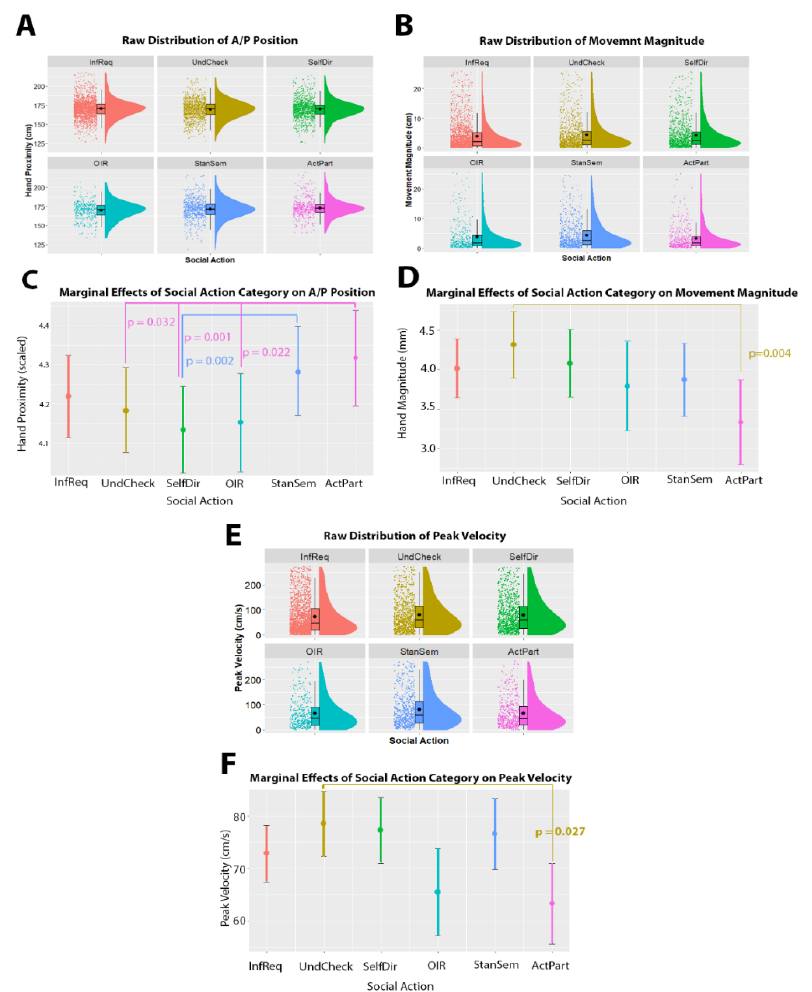
Figure 4. Relationship between hand movement and social action category. Panels ( A , C , E ) show raincloud plots of the raw distribution ( y -axis) across each of the social action categories ( x -axis). The raincloud plots show the overall density of the distribution (shaded curve), the boxplots show the median and interquartile range, while the black dots show the individual data points. Panels ( B , D , F ) depicts the marginal effects of the mixed model (i.e., the predicted values when holding other model terms, such as utterance duration and per-participant intercepts, constant). In panels ( B , D , F ) social action categories are given on the x -axis, and kinematic values are given on the y -axis Note that anterior/posterior position is scaled to range 0.1–15.3. Significant differences between pairs of categories are indicated with colored lines between the categories. P -values are given for each of these comparisons, with the text color corresponding to the larger value in the comparison. Abbreviations: InfReq = Information Request; UndCheck = Understanding Check; SelfDir = Self-Directed Question; OIR = Other-Initiated-Repair; StanSem = Stance or Sentiment; ActPart = Active